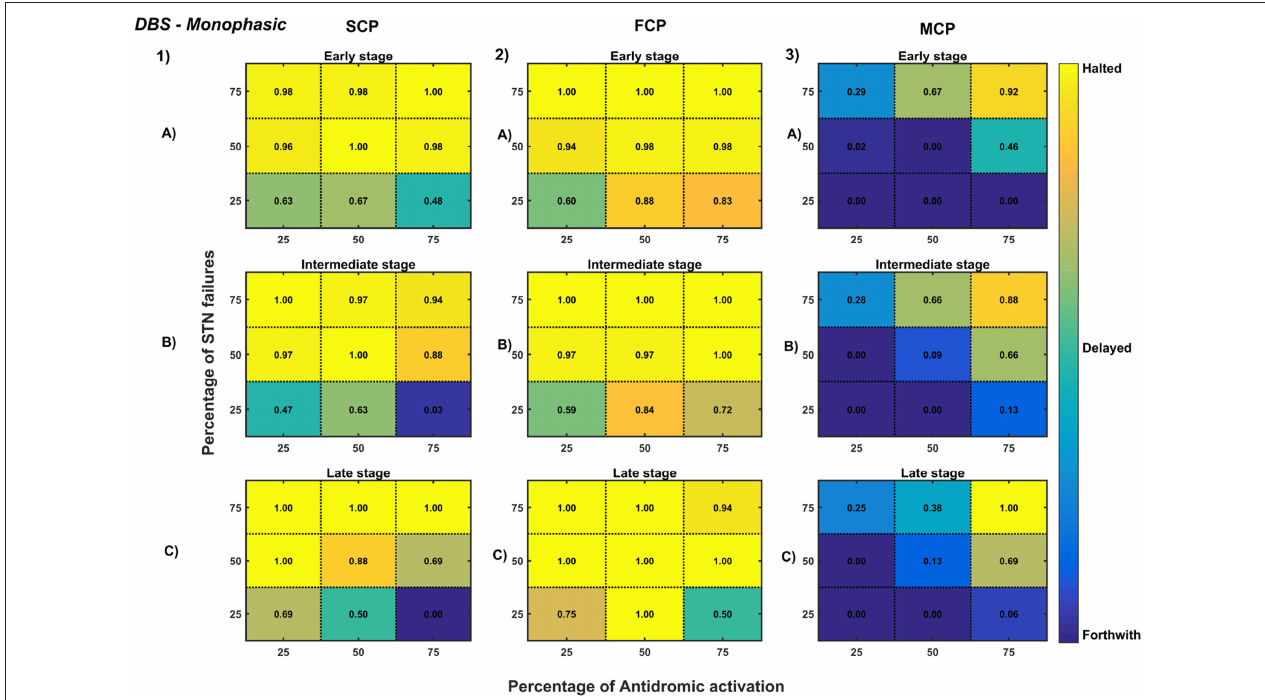
FIGURE 11 | Simulation plots for Monophasic DBS therapy. Profiling of monophasic stimulus waveform for different stimulation configuration in order to achieve the maximal neuroprotective effect of DBS. Confusion matrices for SCP (1) , FCP (2) , and MCP (3) configurations showing survival ratios of SNc cells for different percentage activation of antidromic activation and STN axonal & synaptic failures at early (25%) (A) , intermediate (50%) (B) and late (75%) (C) stages of SNc cell loss. Ratios around 0 is indicated as forthwith (indigo), ratios around 0.5 is indicated as delayed (light green), and ratios around 1 is indicated as halted (yellow). DBS, Deep Brain Stimulation; SNc, Substantia Nigra pars compacta; STN, SubThalamic Nucleus; SCP, Single Contact Point; FCP, Four Contact Point; MCP, Multiple Contact Point.